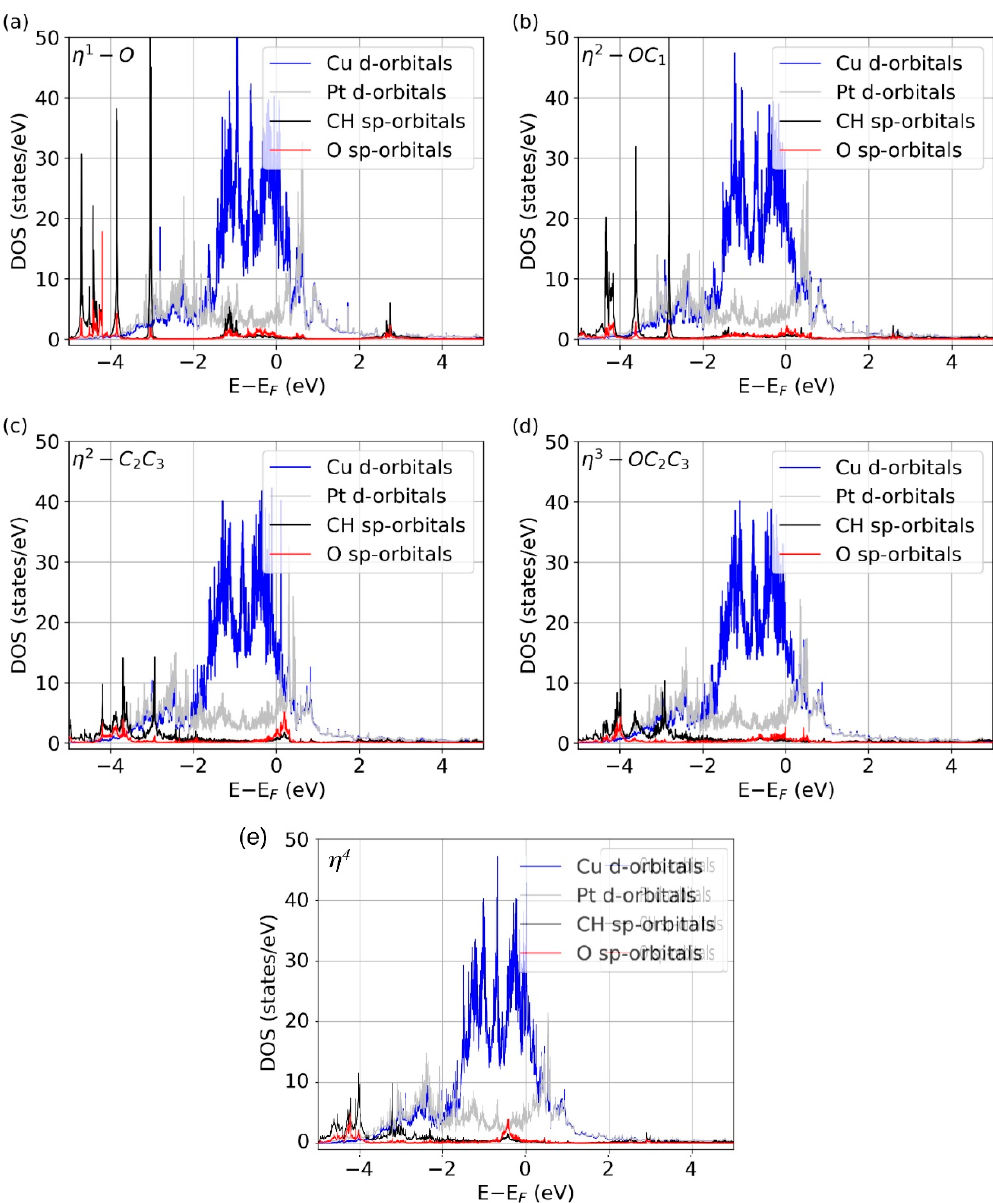
Figure 4. Projected DOS of the E-(s)-cis isomer of crotonaldehyde when adsorbed on the Cu 2 Pt/Cu(111) surface in the ( a ) η 1 -O, ( b ) η 2 -OC 1 , ( c ) η 2 -C 2 C 3 , ( d ) η 3 -OC 2 C 3 , and ( e ) η 4 adsorption configurations.